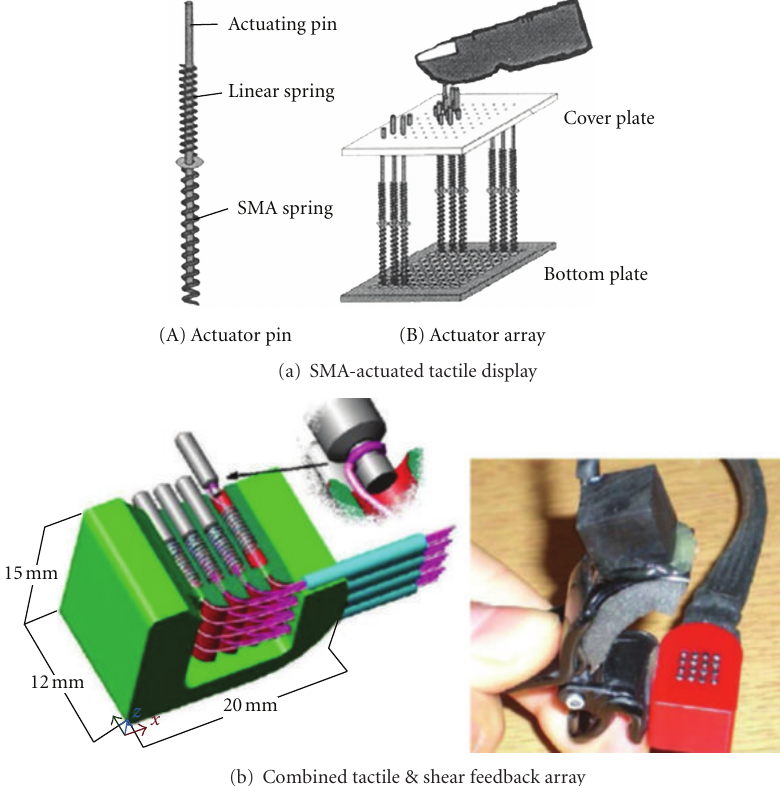
Figure 6: (a) An 8 × 8 actuator array with an SMA-spring actuated principle designed for MIS in the University of Karlsruhe [13]. (b) An integrated tactile and shear feedback 4 × 4 sensor array developed by the University of Salford for stimulation of finger mechanoreceptor. Actuation principle (left) and the device prototype (right) are shown [14].